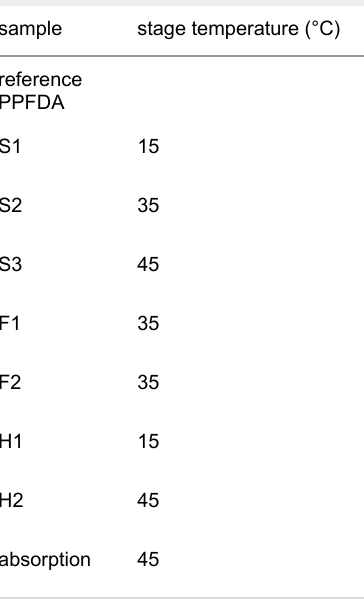
Table 1: XPS survey spectra for PLA lattices.